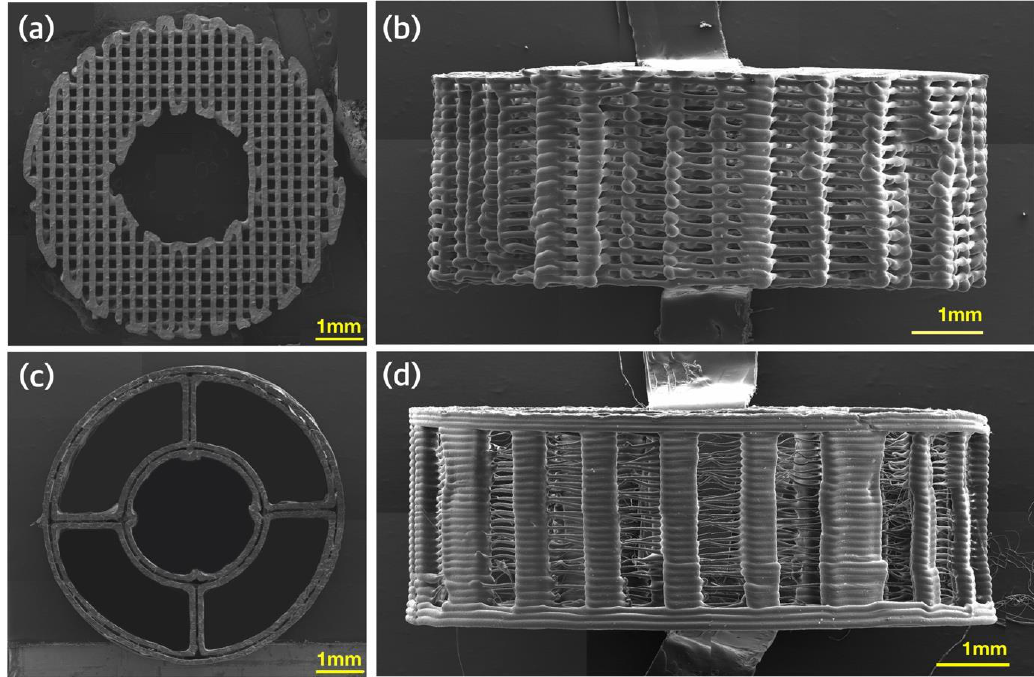
Figure 2. Morphological analysis of three-dimensionally (3D) printed scaffolds using FE-SEM: ( a ) top view of control group I; ( b ) side view of control group I; ( c ) top view of the polycaprolactone (PCL) frame of the hybrid scaffold; and ( d ) side view of the PCL frame of the hybrid scaffold.